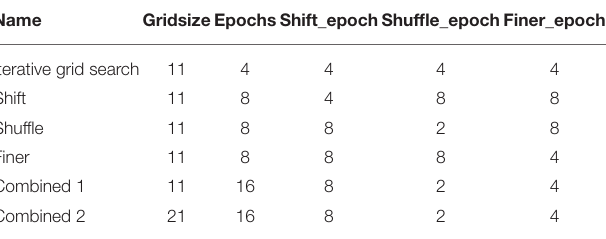
Algorithm 6 . Shift , Shuffle , and Finer exclusively showed the